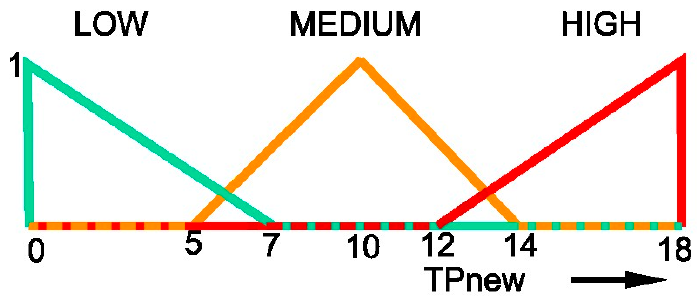
Figure 3. TPnew membership function .